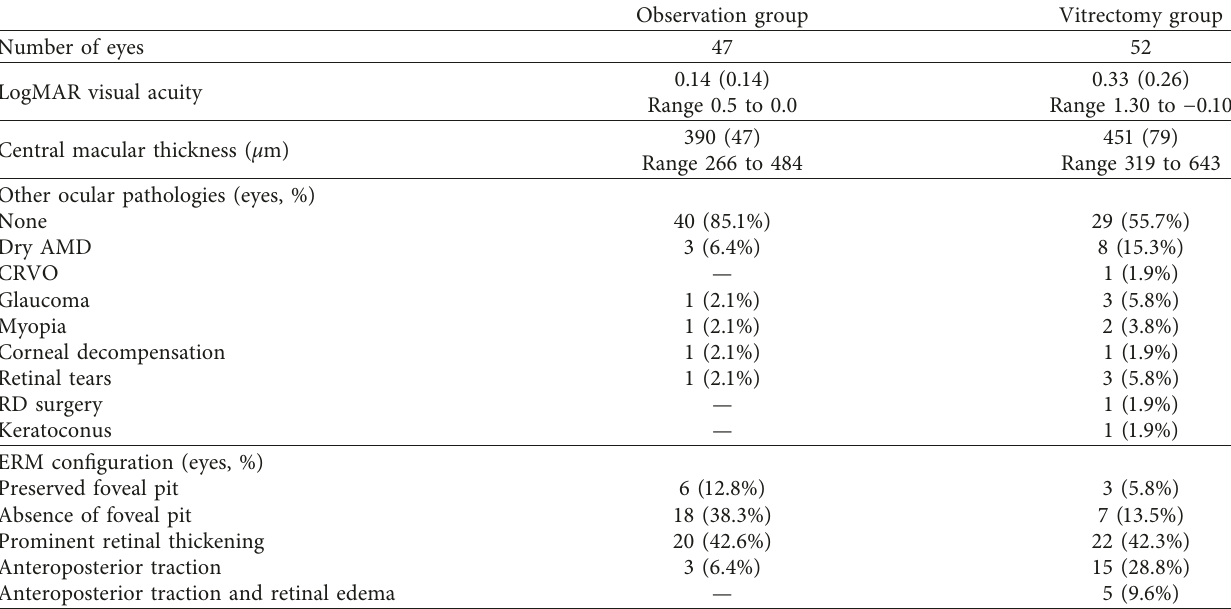
Table 1: Characteristics at the time of diagnosis of epiretinal membrane. Values provided for visual acuity and central macular thickness are mean (standard deviation) and range.